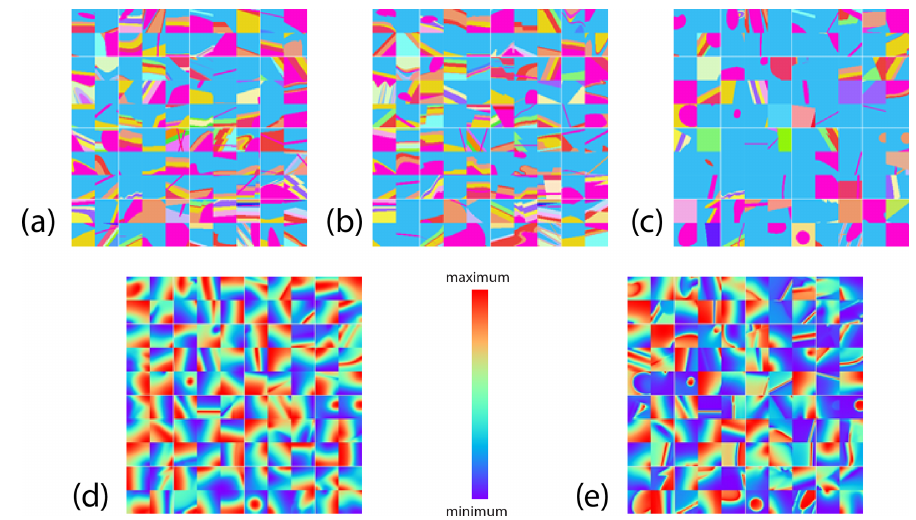
Figure 2. Example models for 100 randomly selected models drawn from the 1-million-model suite showing (a) the top surface of the model, (b) an E–W section at the northern face of the model looking from the south, (c) a N–S section on the western face of the model looking from the west, and the resulting (d) gravity and (e) magnetic fields. Geophysical images are all normalised to model max–min